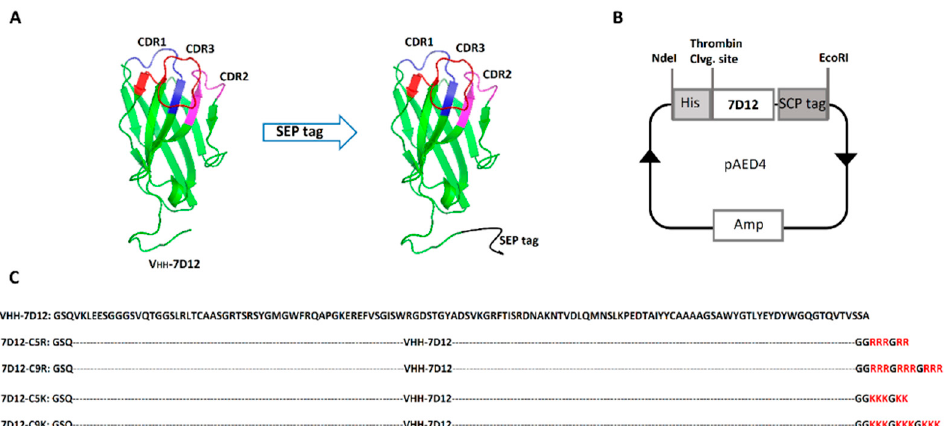
Figure 1. Sequence and schematic structure of the tagged V HH -7D12. ( A ) Ribbon structure of anti-EGFR V HH -7D12 and SEP tagged V HH -7D12 generated by Pymol [31] using the crystal structure of V HH -7D12 (PDB: 4KRL) [32]. The SEP tag is shown in black and was generated using Modeller. ( B ) Schematics of the anti-EGFR V HH expression vector. ( C ) The amino acid sequence of V HH -7D12. The arginine and lysine tags were attached to the C-termini of V HH